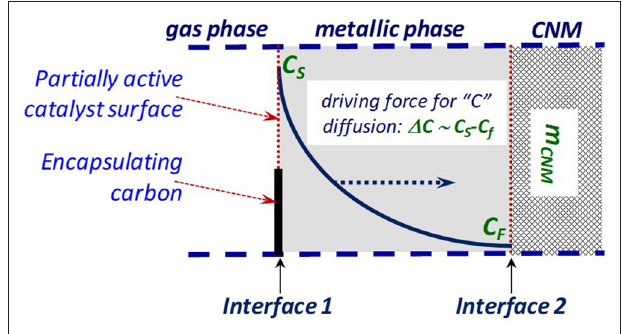
FIGURE 1 | Scheme of the mechanism of formation of carbonaceous nanomaterials by catalytic decomposition of hydrocarbons.